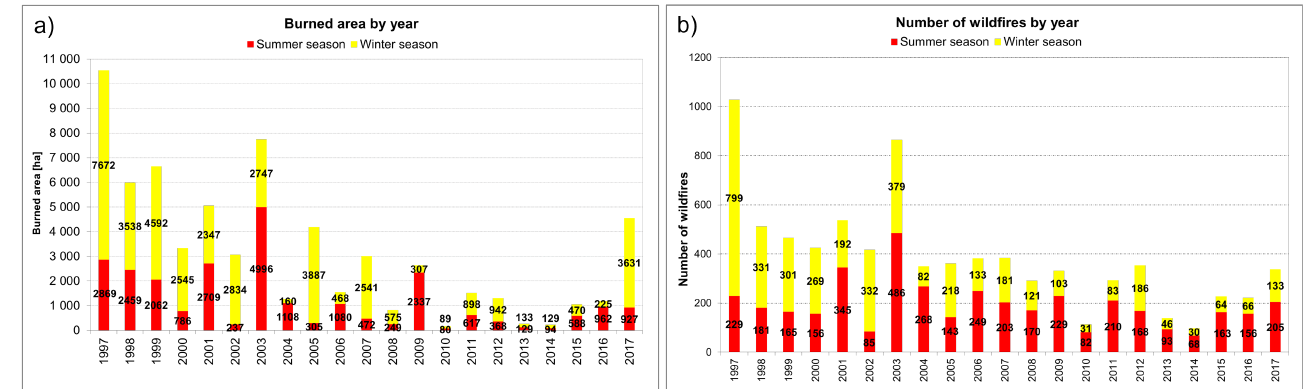
Figure 2. Yearly burned area ( a ) and number of fires ( b ) in Liguria during the summer and winter in the period 1997–2017.